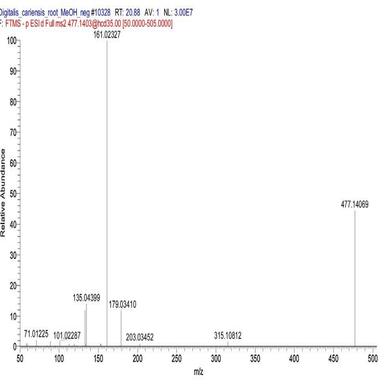
MS2 spectrum of phenylpropenoate glycoside at retention time 20.84 minutes.